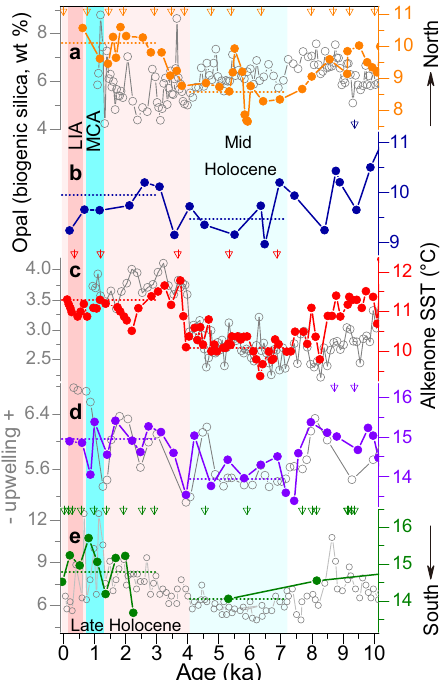
Fig. 2 Sea surface temperature (SST) records in the western Paci fi c margin. Reconstructed SST changes for ( a ) site 7 in the downstream region of the Kuroshio Current (KC) 36 , ( b ) stacked SST anomaly (SSTA) at six sites across the Okinawa Trough, ( c ) stacked SST anomaly (SSTA) at six sites (16 – 21 in Fig. 1a) in the Western Paci fi c Warm Pool (WPWP) and ( d ) SST gradient between the KC path and WPWP region (difference in their stacked SST anomalies). Blue bars highlight the reduction of the KC strength during the mid-Holocene and Medieval Climate Anomaly (MCA), and red bars mark its intensi fi cation during the past 3000 – 4000 years and the Little Ice Age (LIA). Shadings ( b , c ) of proxy records show one standard deviation error ( “ Methods ” ).